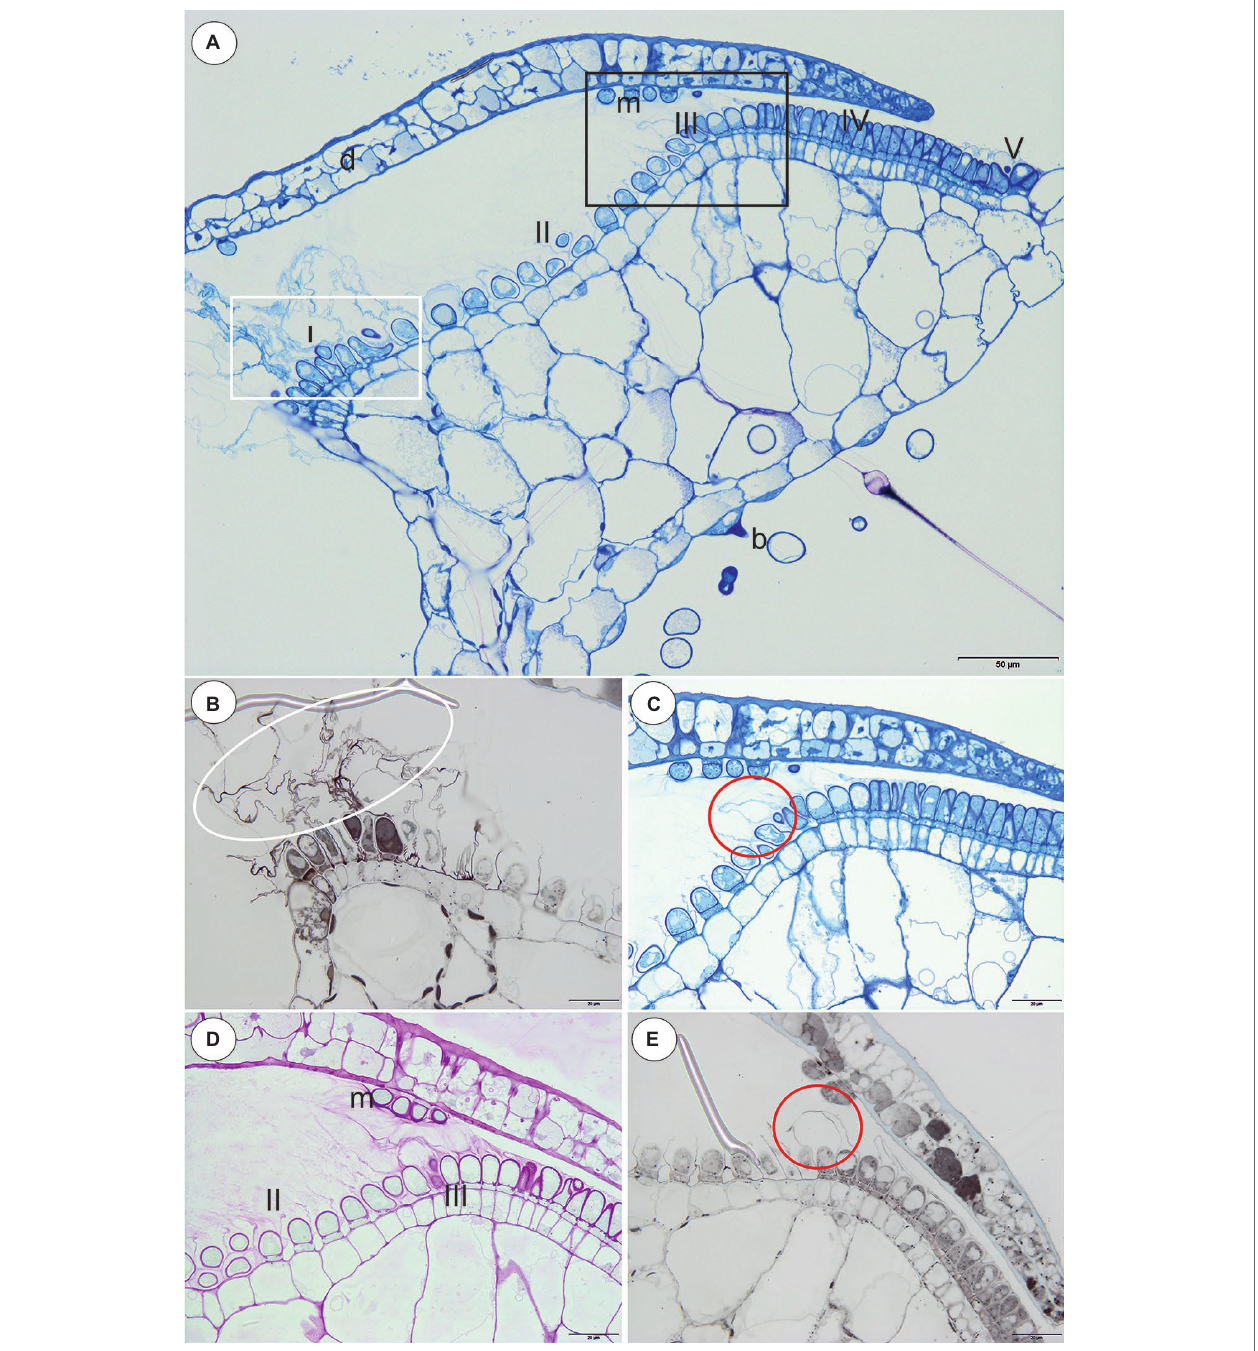
FIGURE 2 | Structure and cytochemistry of the pavement epithelium of Utricularia dichotoma . (A) A semi-thin longitudinal section of the threshold showing the zones of the pavement epithelium: zone 1 (I) with an outer velum, zone 2 (II), zone 3 (III) with an inner velum, zone 4 (IV), zone 5 with mucilage trichomes (V), door (d), door mucilage trichomes (m), bifids (b); the sub-region marked by white box was shown in higher magnification at (B) , the sub-region marked by black box was shown in higher magnification at (C,D) ; scale bar = 50 μ m. (B) A semi-thin longitudinal section of the threshold of the external part showing the trichomes that produce the outer velum (white ellipse). The lipid stain SBB was absorbed by the cuticles; scale bar = 20 μ m. (C) A semi-thin longitudinal section of part of the threshold showing zone 3 of the pavement epithelium with the trichomes that produce the inner velum (circle); scale bar = 20 μ m. (D) The same as in C but after the PAS reaction, note the intensive mucilage production in zones 1 (II) and 3 (III) of the pavement epithelium, and also the mucilage trichomes on the surface of the door (m); scale bar = 20 μ m. (E) A semi-thin longitudinal section of the part of the threshold showing zone 3 of the pavement epithelium with the trichomes that produce the inner velum (circle). The lipid stain SBB was absorbed by the cuticles; scale bar = 20 μ